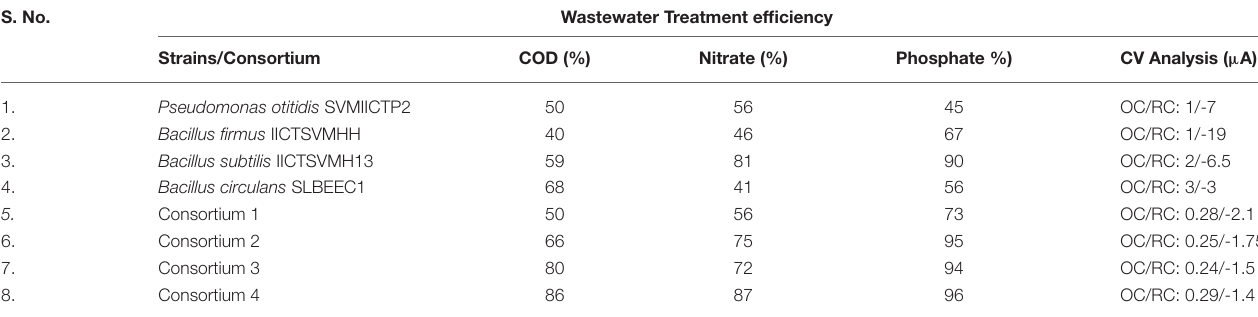
TABLE 3 | Comparative evaluation of synthetic consortia with the single strains for their wastewater treatment potential. S.